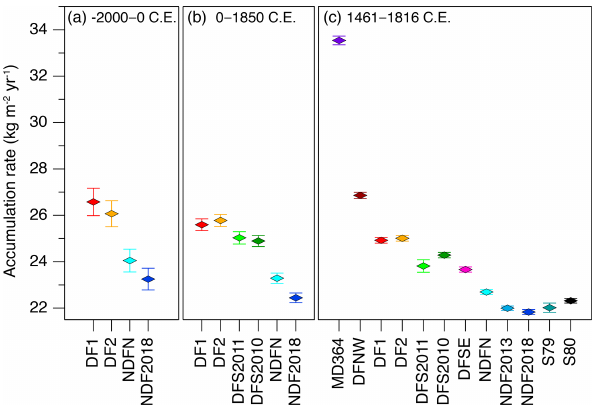
Figure 7. Mean accumulation rate over three periods: (a) 2000BCE–1CE, (b) 1–1850CE, and (c) 1461–1816CE. Error bars represent the 2 σ uncertainty of the mean accumulation rate over the respective periods (combined uncertainties in age, density and